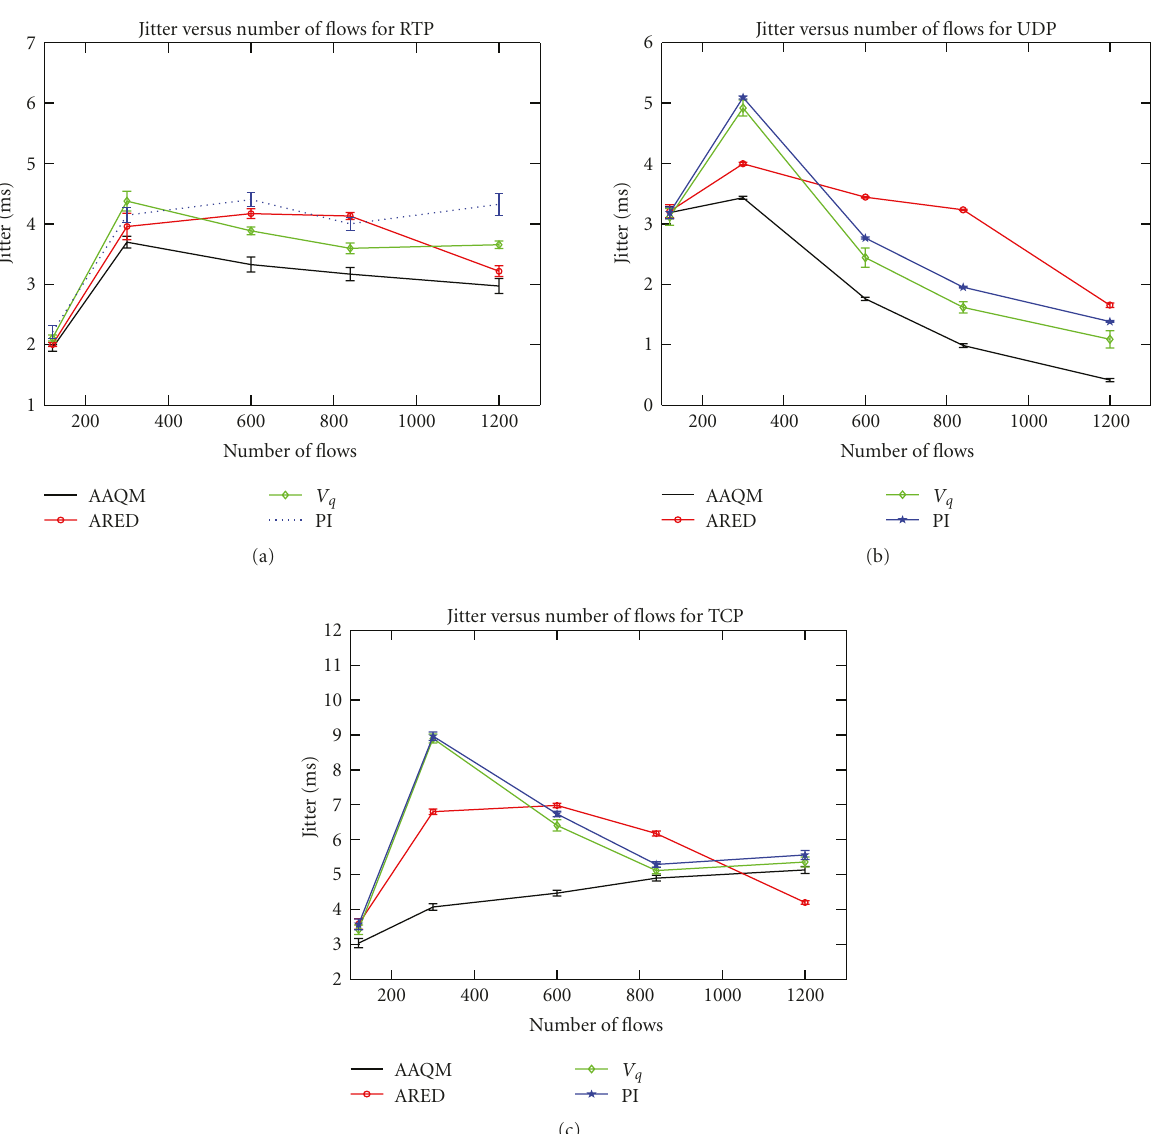
Figure 13: Jitter for (a) Video Tra ffi c (b) Multimedia Tra ffi c (c) TCP tra ffi